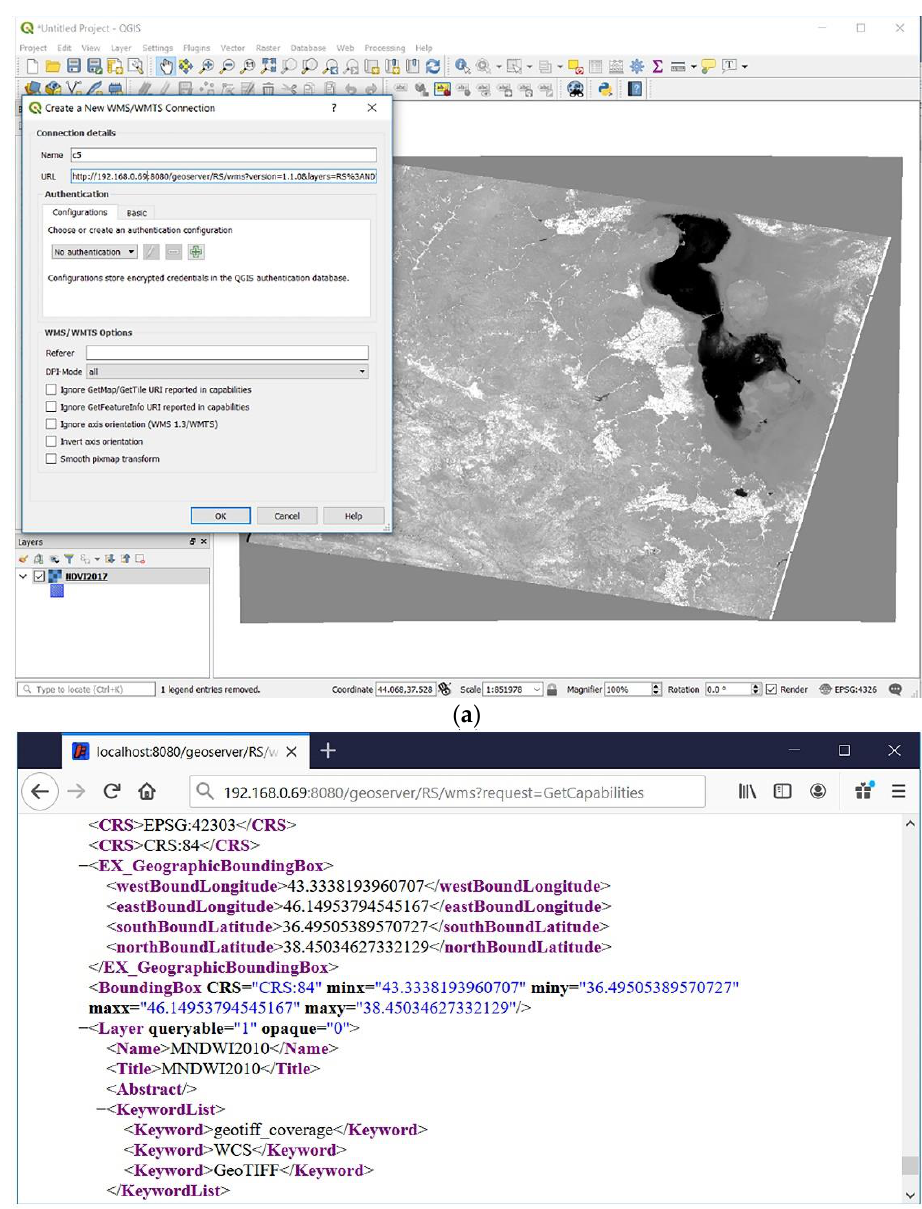
Figure 14. ( a ) Adding the Web Map Service (WMS) layer of a crowdsourced NDVI product (for an area located in West Azerbaijan and West Azerbaijan Provinces, Iran) into the QGIS software using the URL provided by the service; ( b ) accessing the service-level metadata for the WMS layer of crowdsourced MNDWI product (for an area located in West Azerbaijan and West Azerbaijan Provinces, Iran) using the WMS GetCapabilities method.